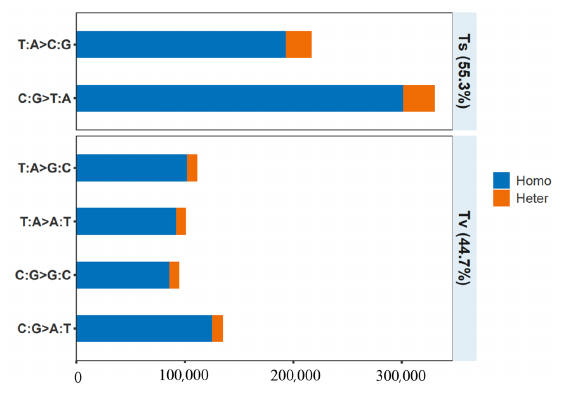
Figure 2. SNP mutation spectrum analysis.